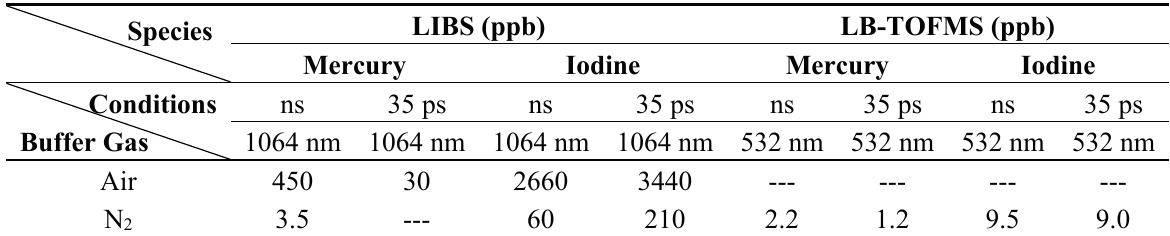
Figure 14. LB-TOFMS measurement of concentration dependence of Hg + signal intensity using ns 532 nm laser irradiation. Conditions: buffer gas N 2 , power 110 mJ/p, pressure 0.056 Pa, lens angle α 10°. Table 4. Detection limits of Hg and iodine under different